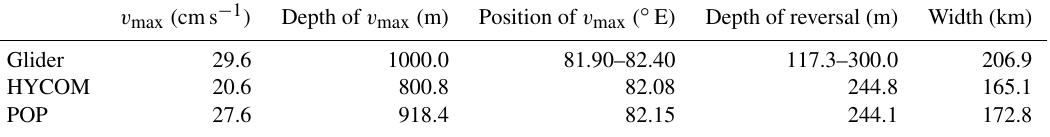
Table 2. Same as Table 1 but for